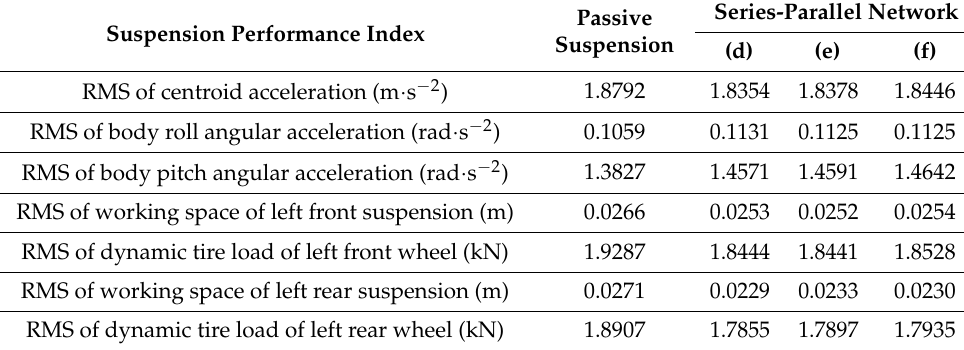
Table 4. RMS comparison of mechatronic inertial suspension based on the series-parallel network. Suspension Performance